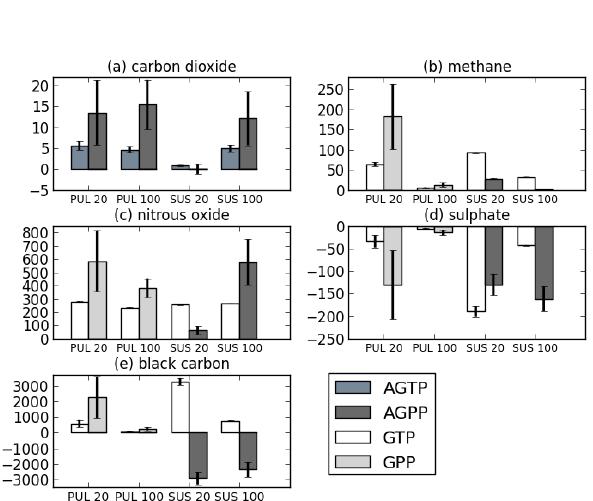
Figure 9. Mean and standard deviations of the AGTP, AGPP, GTP and GPP for both pulse (PUL) and sustained (SUS) emis- sions for time horizons of 20 and 100 years (which are cho- sen for illustrative purposes), using 18 different representa- tions of the impulse response function for temperature change. (a) AGTP and AGPP for carbon dioxide, for both pulse and sustained emissions, and then GTP P , GPP P , GTP S and AGPP S for (b) methane, (c) nitrous oxide, (d) sulphate and (e) black carbon. For CO 2 the units are 10 − 16 Kkg − 1 for AGTP P , 10 − 14 Kkg − 1 yr for AGTP S , 10 − 18 mmday − 1 kg − 1 for AGPP P and 10 − 16 mmday − 1 kg − 1 yr for AGPP S . The AGPP S for all other gases are in 10 − 15 mmday − 1 kg − 1